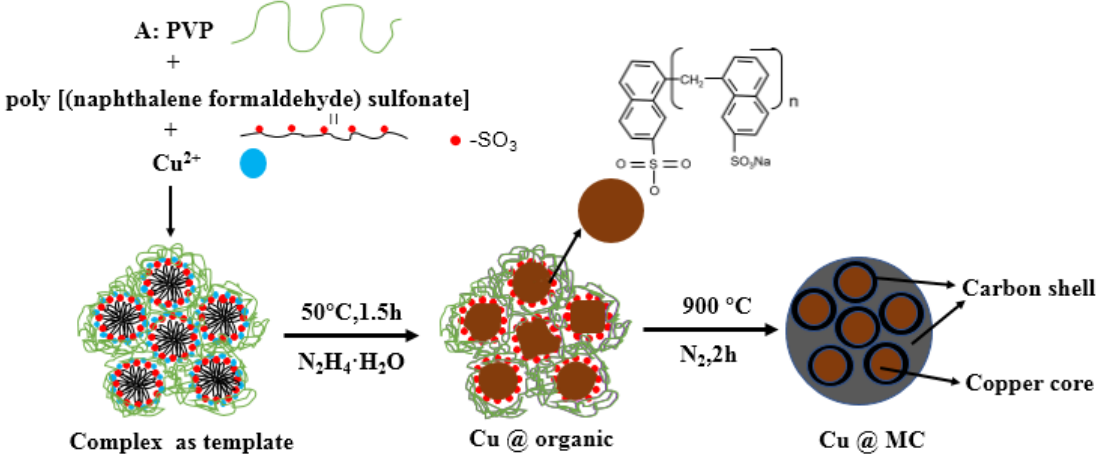
Figure 1. Scheme of synthesis process of Cu@MC and corresponding photographs of the samples. ( a ) A-B-Cu 2+ complex; ( b ) A-B-Cu(OH) 2 complex; ( c ) Cu 2 O colloid; ( d ) Copper colloid; ( e ) Cu@organic; ( f ) Cu@MC.